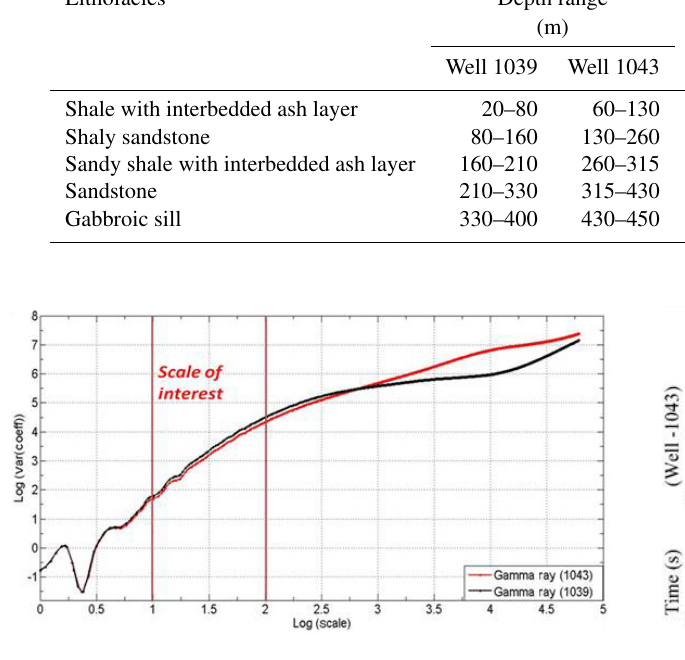
Figure 5. Scale of interest showing variance of wavelet coefficients versus scale of gamma ray of well sites 1039 and 1043.